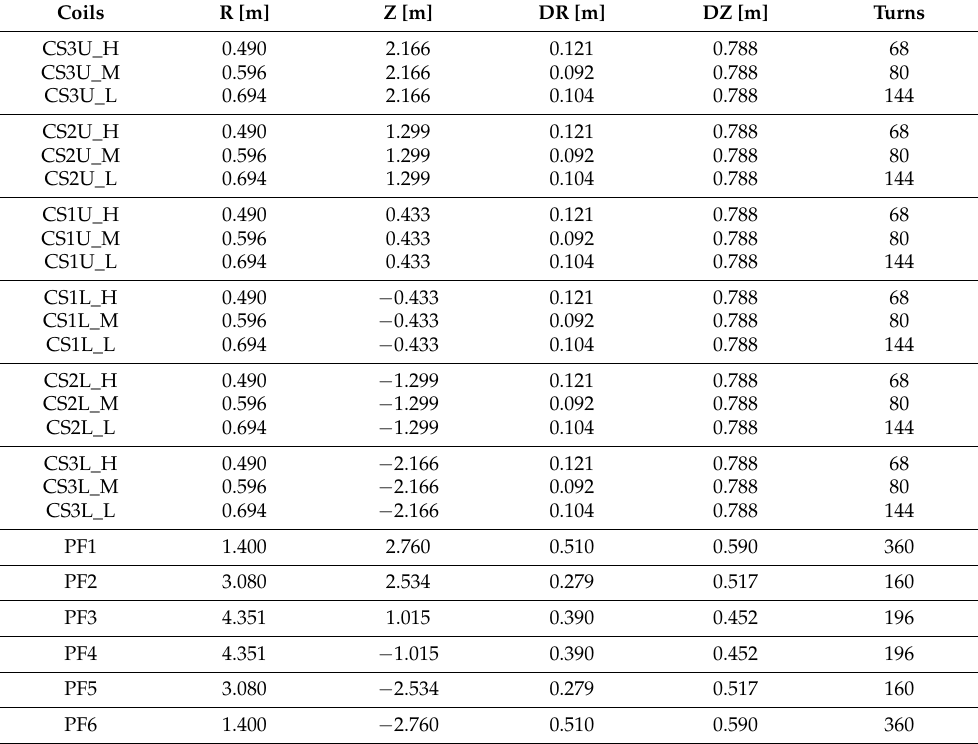
Table 2. DTT superconducting coils: coordinates, dimensions and number of